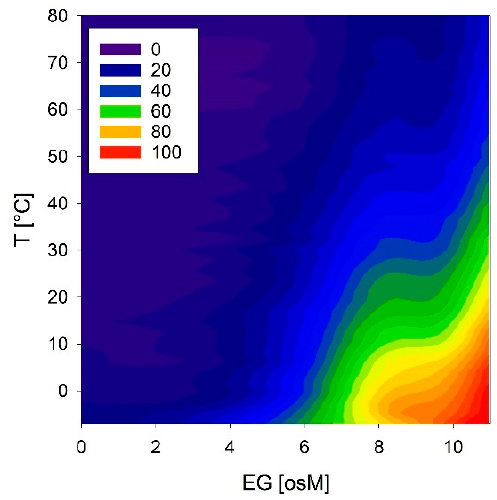
Figure 12. Temperature and osmolarity dependent conformational changes of COR15A estimated from the ellipticity at 222 nm. Color codes correspond to the percentage of α -helicity.